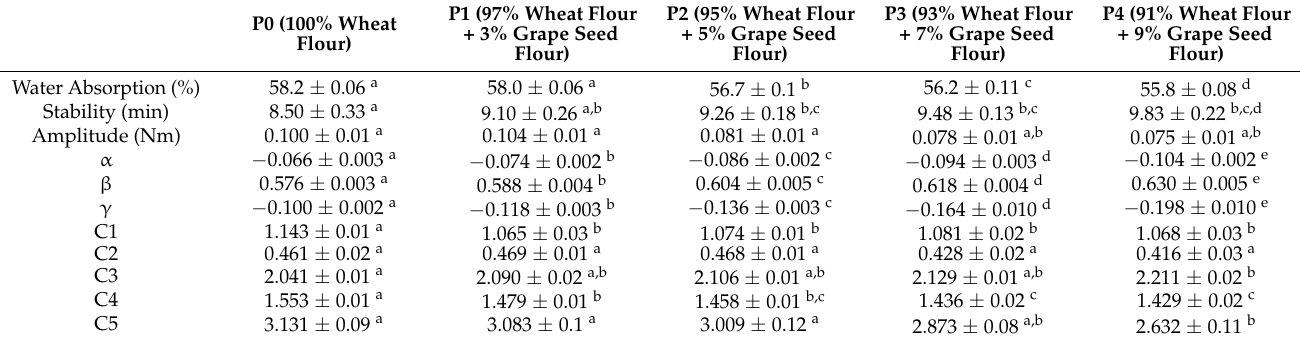
Table 7. Rheological characteristics of 100% wheat flour and flour mixtures.